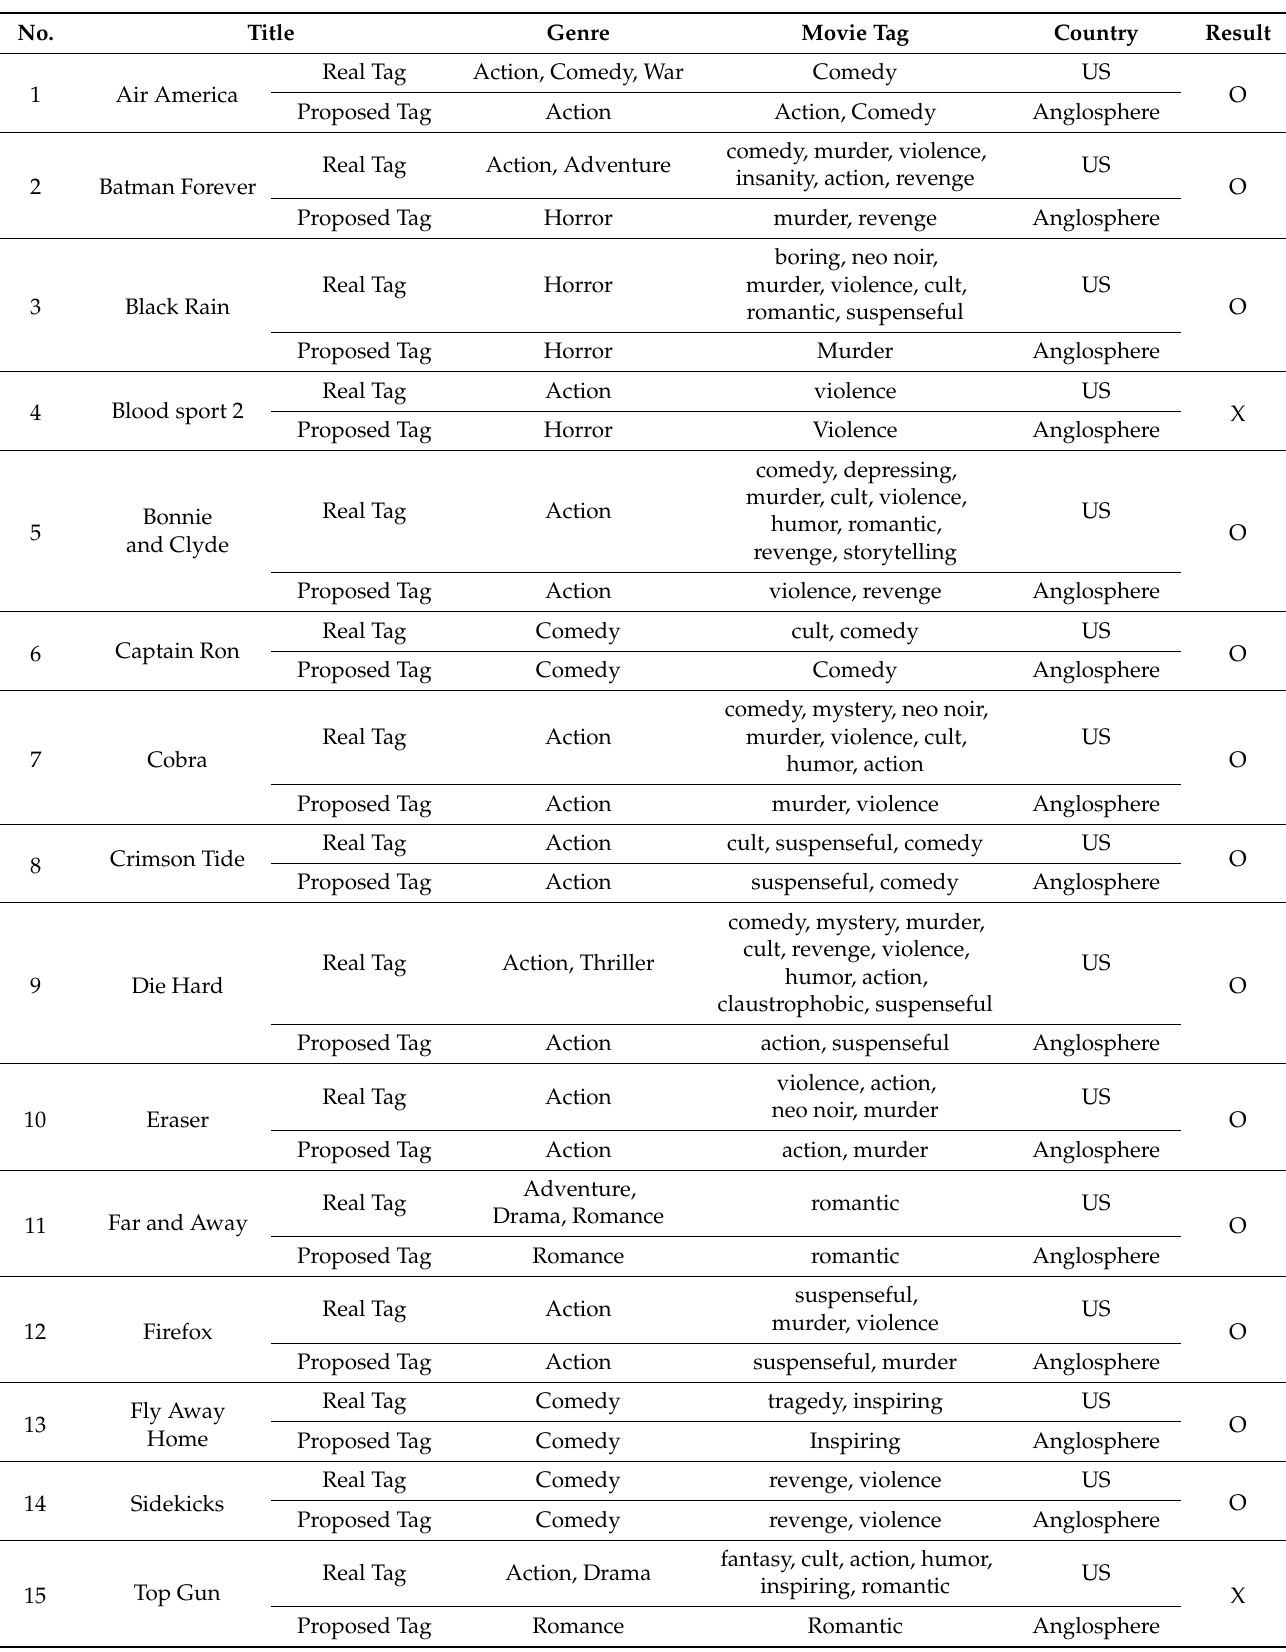
Table 4. Comparison of real tags and tags generated from the proposed system (15 randomly selected in